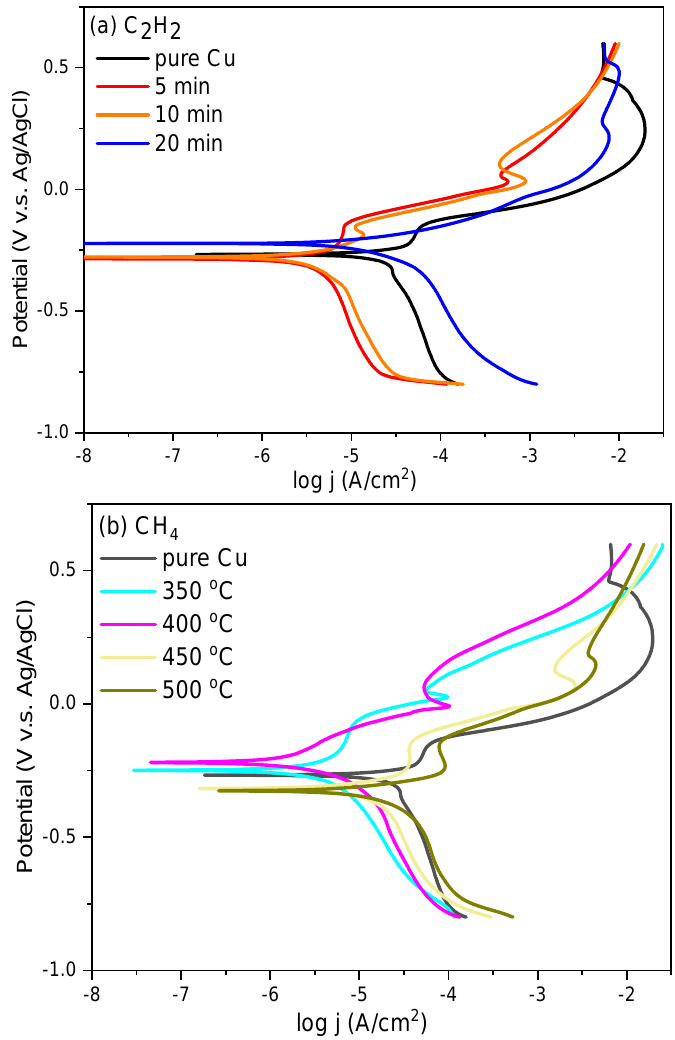
Figure 3. Potentiodynamic polarization curves of Cu and LTCVD graphene nanostructures grown on Cu using ( a ) C 2 H 2 at 600 ◦ C for different times and using ( b ) CH 4 at different temperatures for 5 min for the first scan (electrolyte: 3.5 wt.% NaCl solution, scan rate: 10 mV/s).